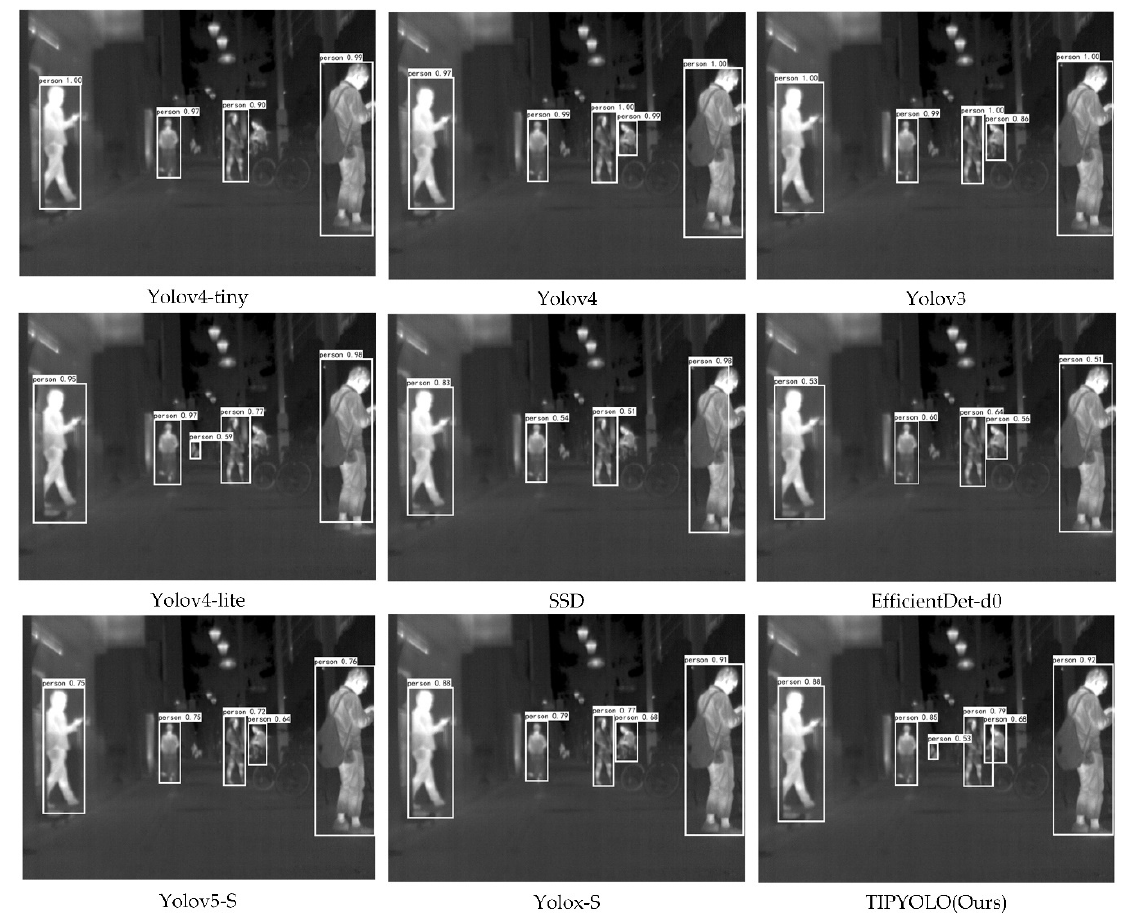
Figure 11. The detection results of YIPYOLO and other methods on the UTMD dataset.